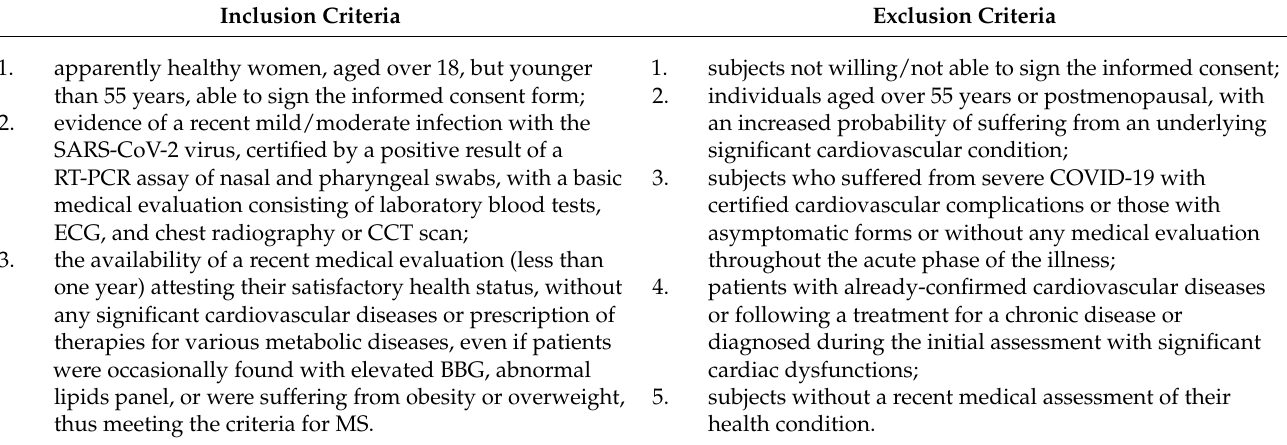
Table 1. Inclusion and exclusion